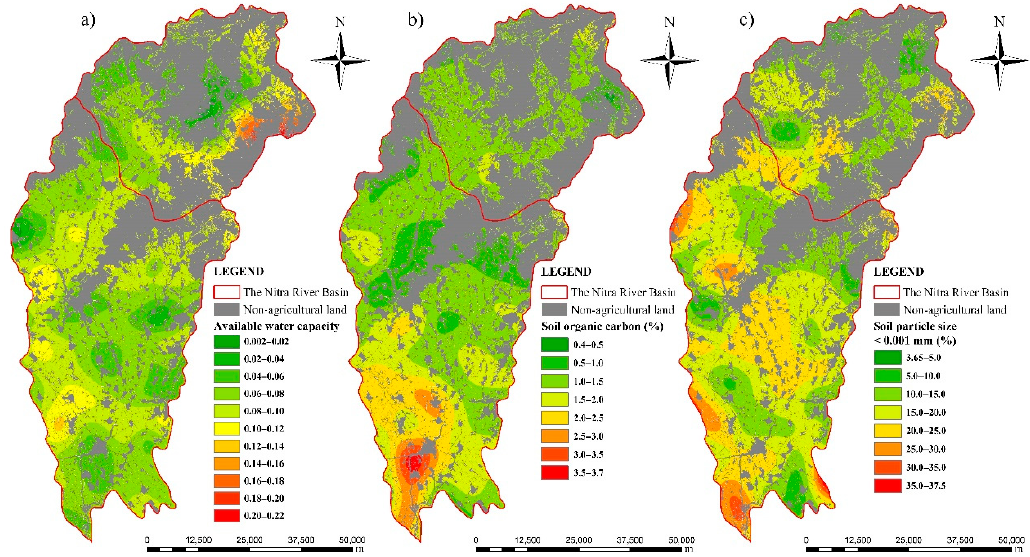
Figure 8. The spatial distribution on agricultural land in the studied basin as estimated by GRASS GIS Spline method: ( a ) Available water capacity; ( b ) Soil organic carbon content; ( c ) Clay fraction content.